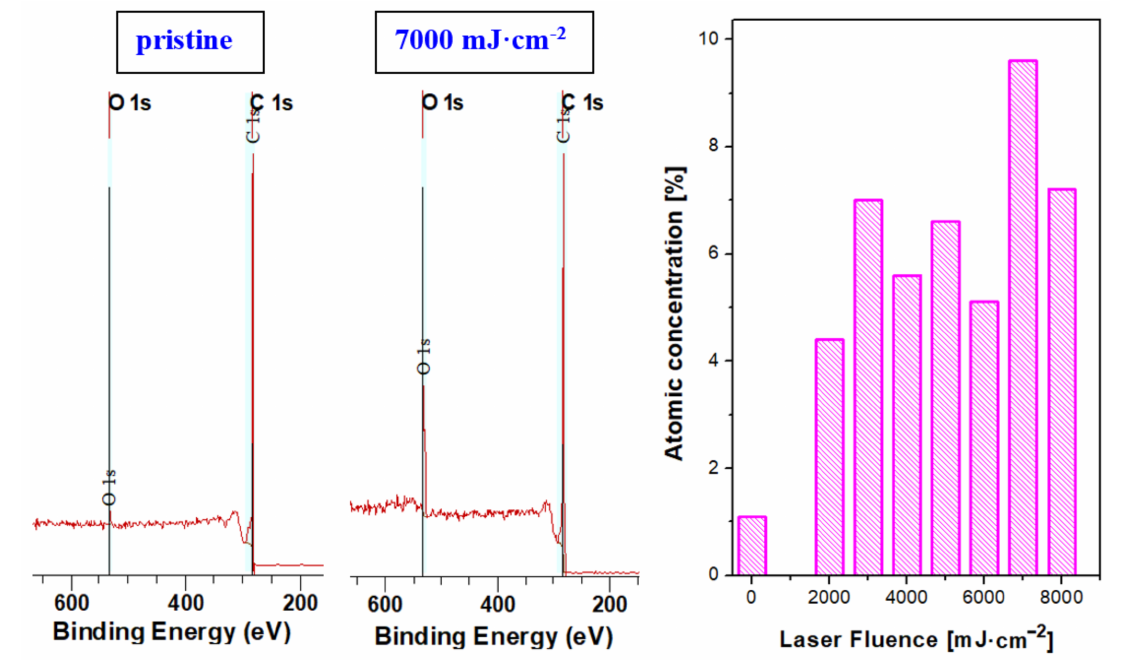
Figure 9. Selected XPS spectra of pristine carbon foil and carbon foil exposed with an excimer laser and fluence 7000 mJ · cm − 2 . On the left, the oxygen surface atomic concentrations for pristine carbon foil and carbon foil treated in interval from 2000 mJ · cm − 2 to 8000 mJ · cm − 2